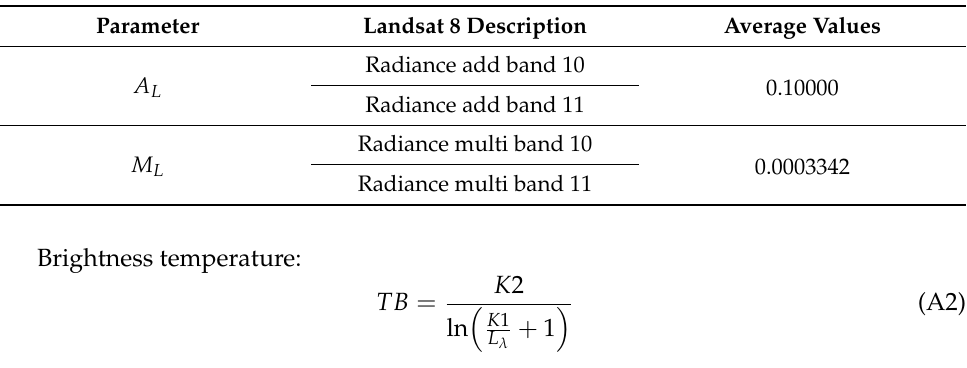
Table A1. Constant used to calculate radiance.